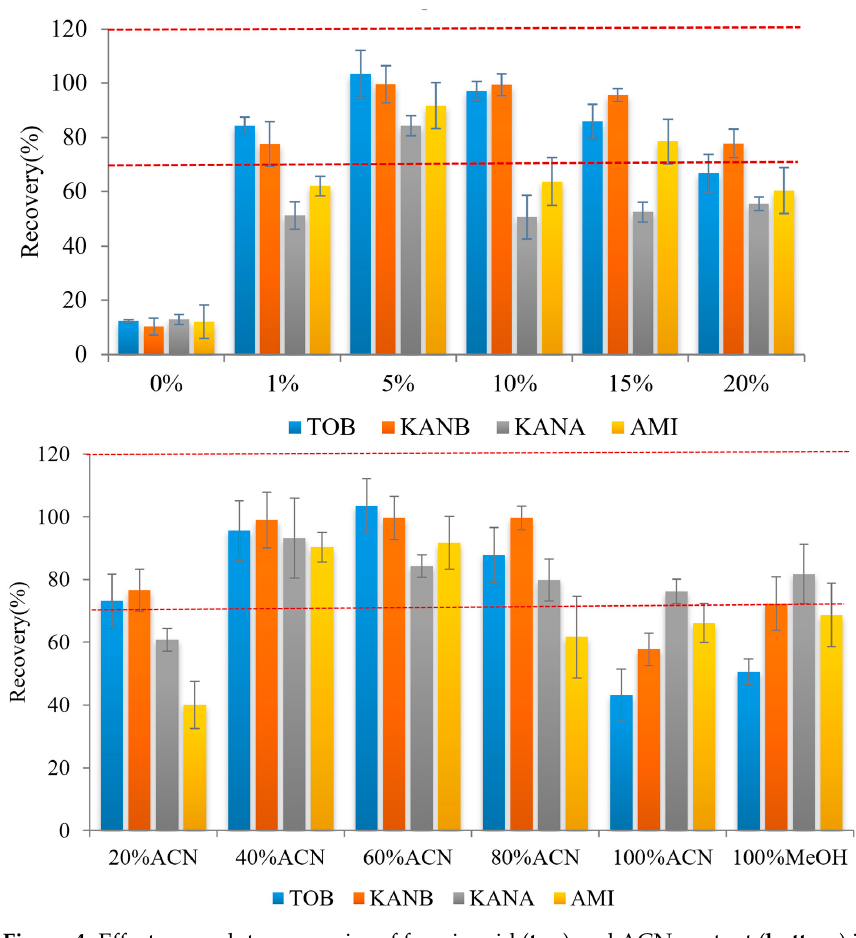
Figure 4. Effect on analyte recoveries of formic acid ( top ) and ACN content ( bottom ) in the elution mixture ( n = 3) (Red dash lines reprensents the recoveries form 70% to 120%).